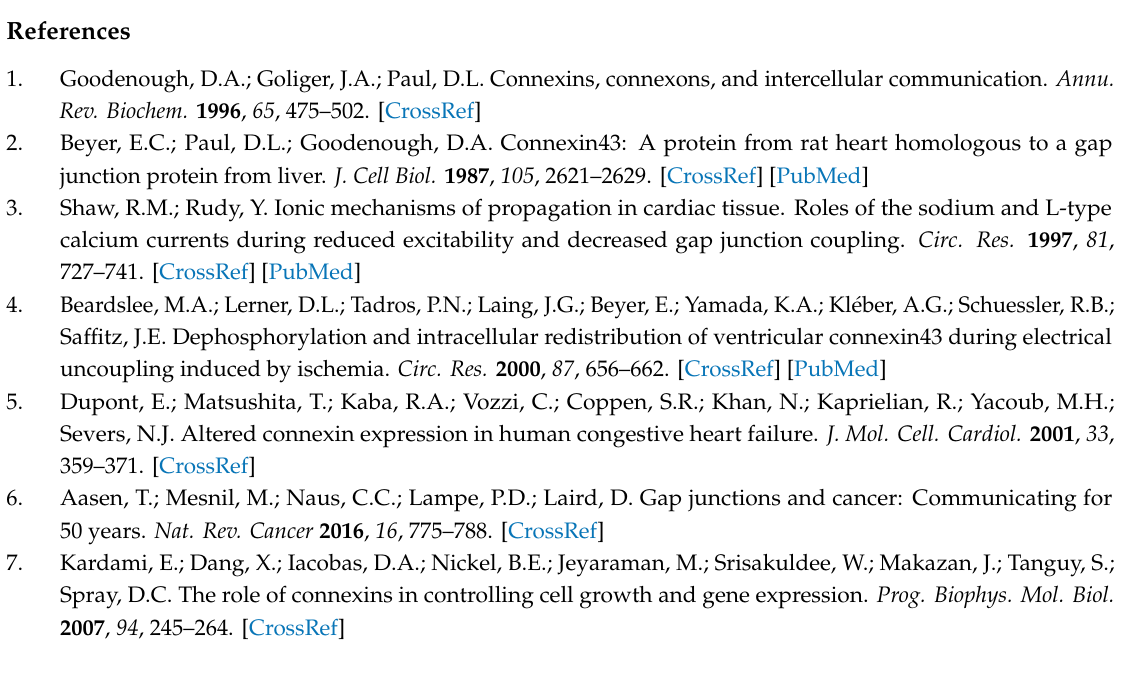
Figure S1: title, Table S1: title, Video S1: